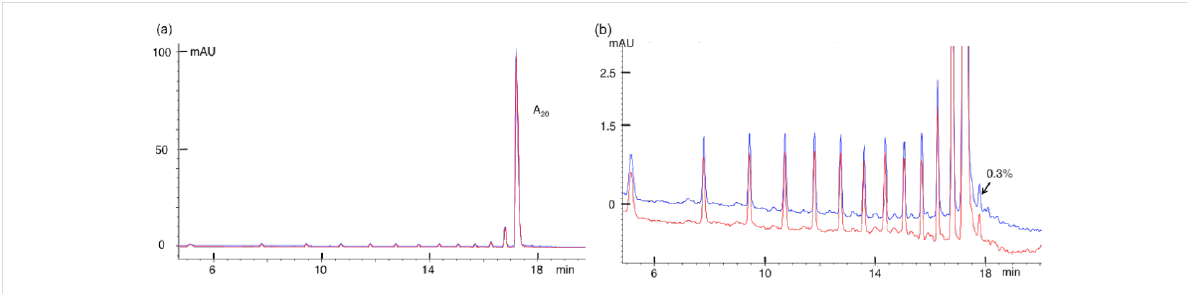
Figure 4: Overlapping HPLC profiles of A 20 before (red) and after (blue) osmylation to show no detectable reactivity of A with OsBp. (a) Oligo, about 85% pure, in full scale, and (b) the magnification to show the presence of small impurities, the shorter oligos with n − 1. The chromatography resolves oligos based on length with n − 1 eluting ahead of n . The impurity at 0.3% of the main peak is marked to visualize the detectability level of this specific experiment.